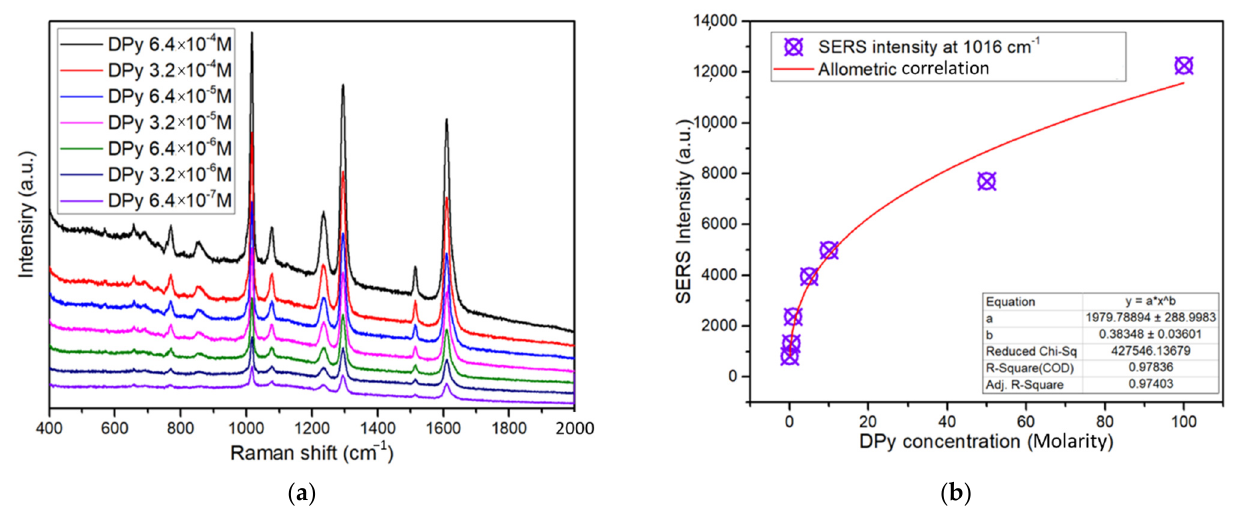
Figure 6. ( a ) SERS detection at various concentrations of DPY with Ag@ZnO-ITO synthesized at an irradiation time of 60 min. ( b ) EF in various concentrations of DPY solution.